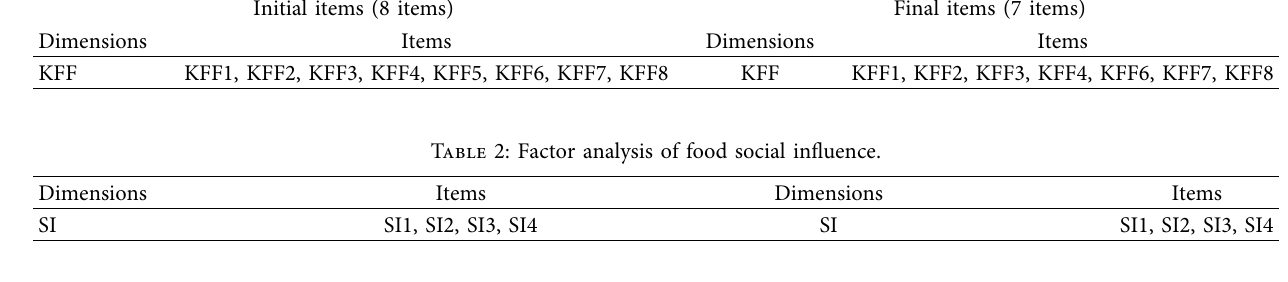
Table 3: KMO and Bartlett’s test.